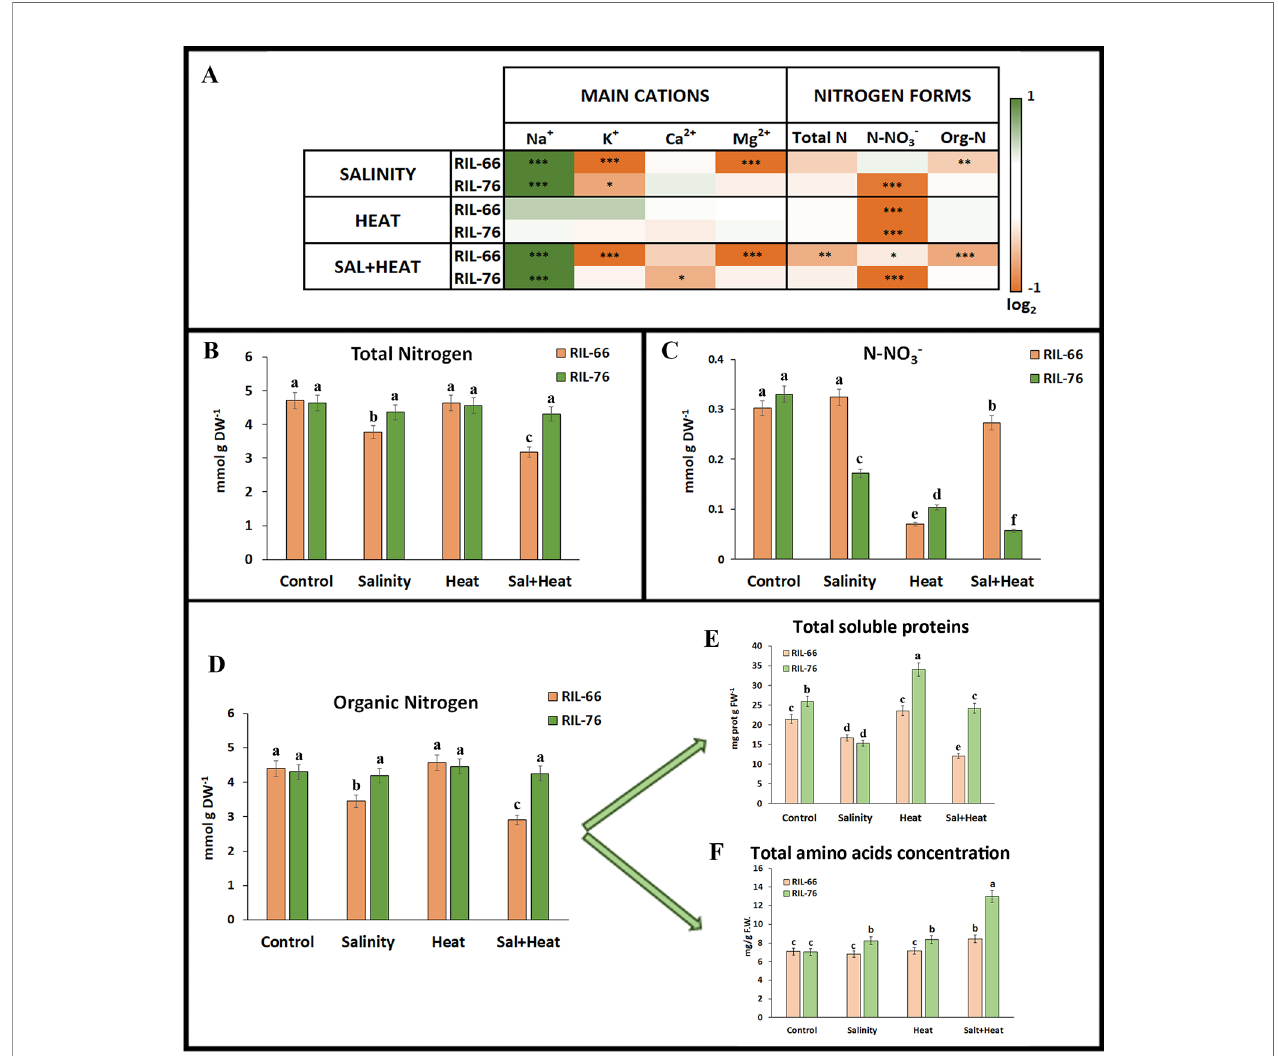
FIGURE 4 | Ionomics in leaves of tomato recombinant inbred line (RIL)-66 and RIL-76 under salinity, heat, or the combination of salinity and heat. (A) Heat map of the concentration (expressed as log2) of the main cations and nitrogen (N) forms in tomato leaves of RIL-76 (salinity+heat tolerant) and RIL-66 (salinity+heat sensitive) under salinity, heat stress, and the combination of salinity+heat as compared to their controls. ( B – F ) Absolute concentration of total nitrogen (B) , nitrates (C) , organic nitrogen (D) , soluble proteins (E) , and total amino acids (F) obtained in RIL-66 and RIL-76. Bars are mean values ± SE (n = 6), and bars with different letters are signi fi cantly different at p < 0.05 according to Tukey's test. (n = 6). Stars are representative of signi fi cant differences p < 0.05 (*p < 0.05, **p < 0.01, ***p < 0.001) respect to control